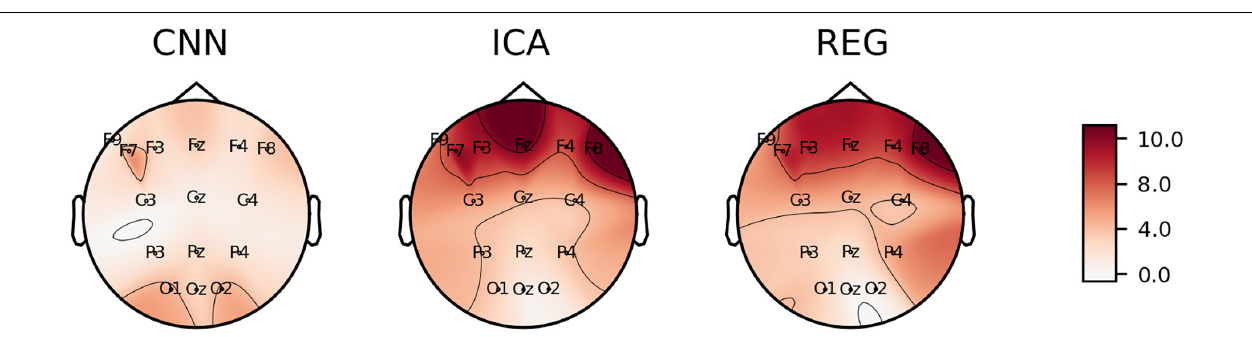
FIGURE 14 | The mean value of MAPE coefficient plotted on the head surface.